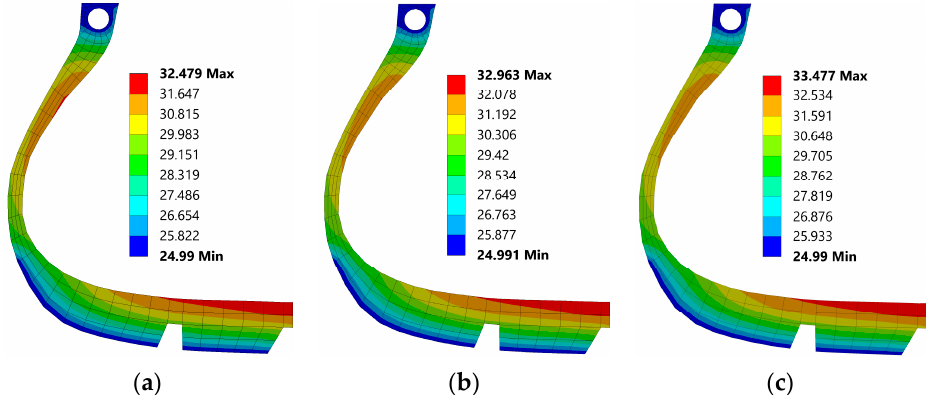
Figure 11. Distribution of temperature within rubber with di ff erent pressures and the loading of 3 kN (unit: °C): ( a ) 30 psi; ( b ) 32 psi; ( c ) 34 psi.